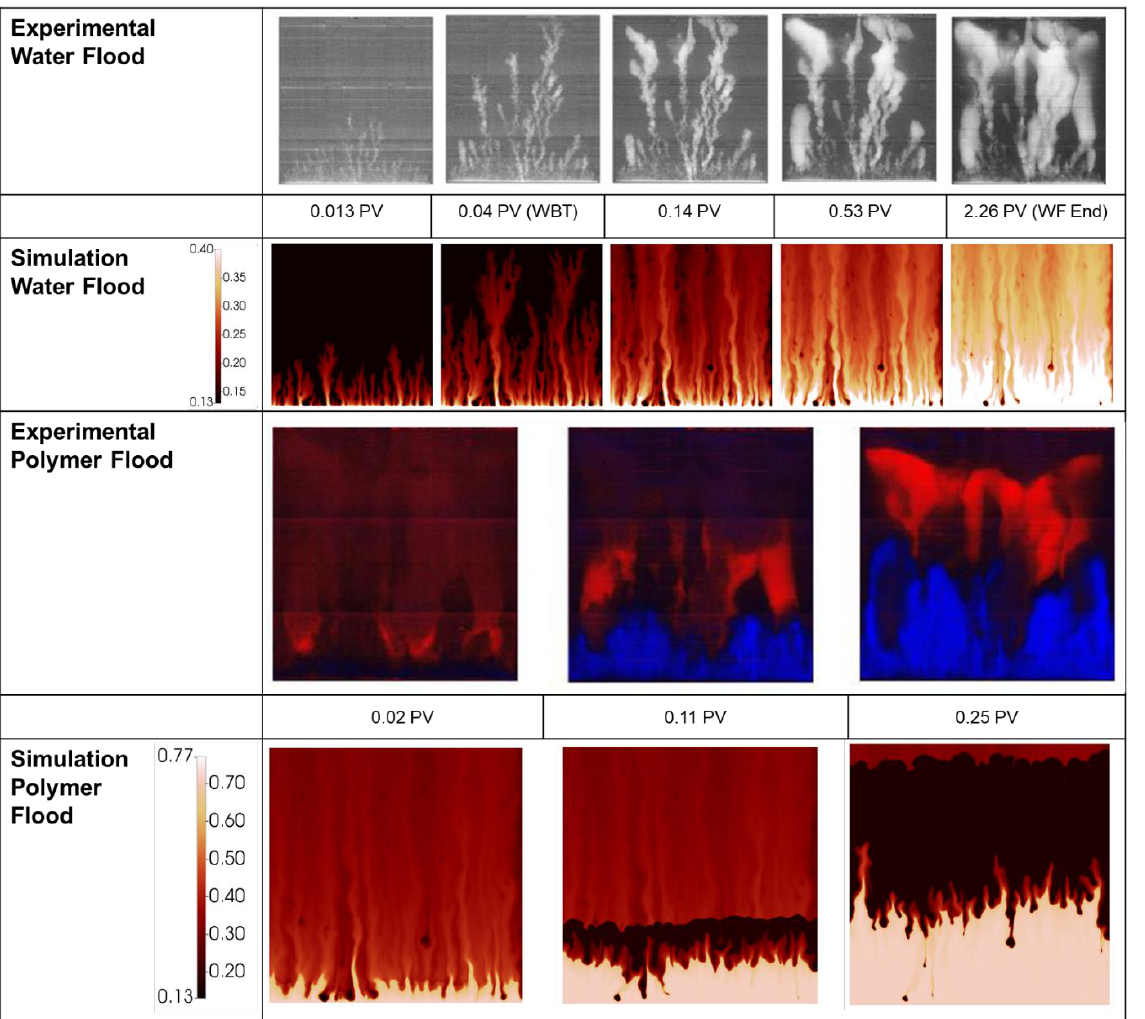
Figure 5. Experimental vs. simulated finger patterns during displacement of 2000 mPa.s oil.